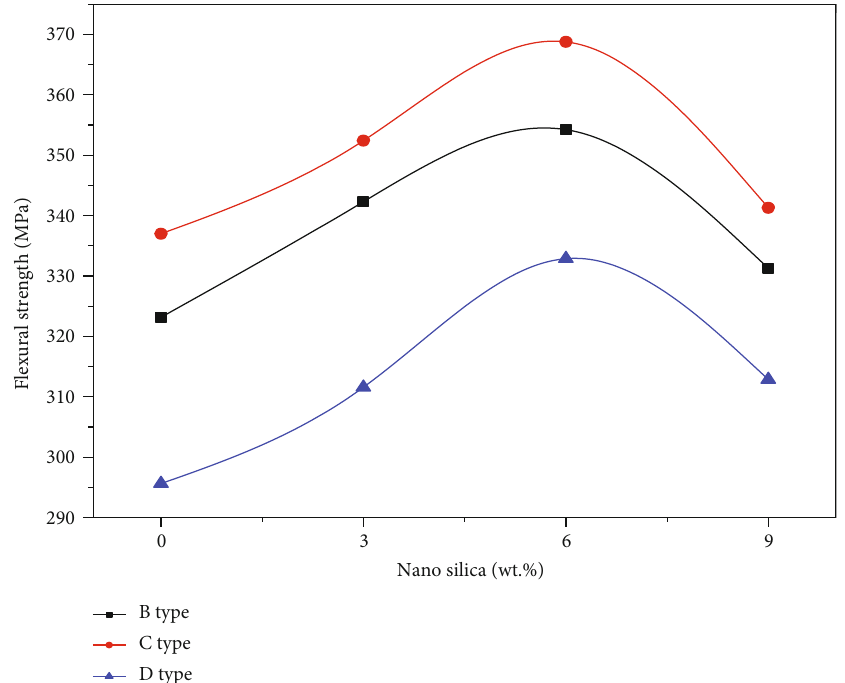
Figure 8: Flexural strength of nanocomposites based on the wt.% of nanosilica.